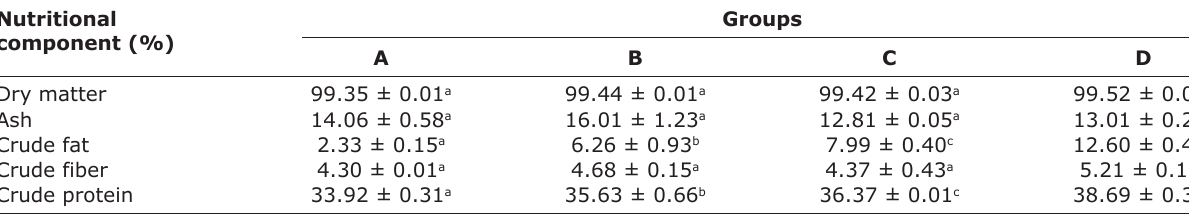
Table-2: Nutritional composition(%, DW) of experimental feed. Nutritional component (%)